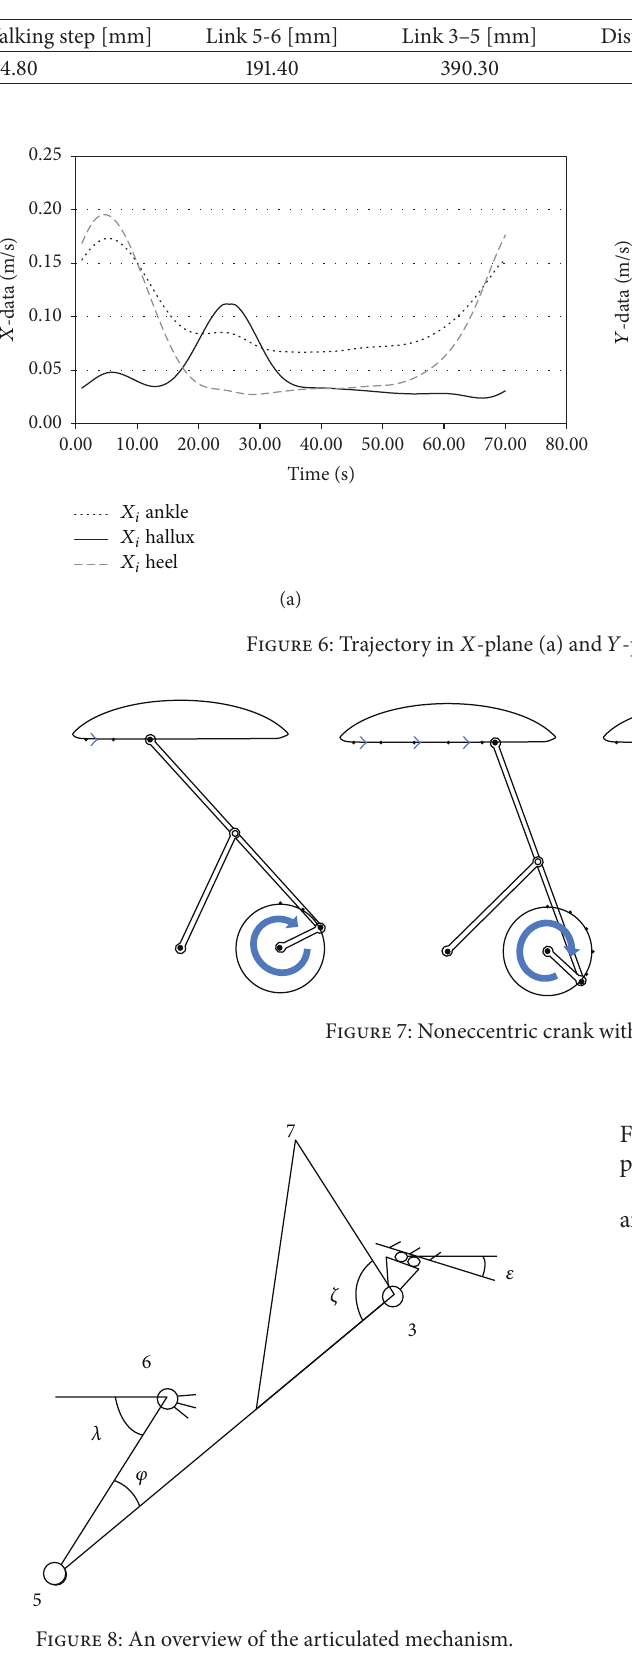
Table 2: Parameters of the articulated system.